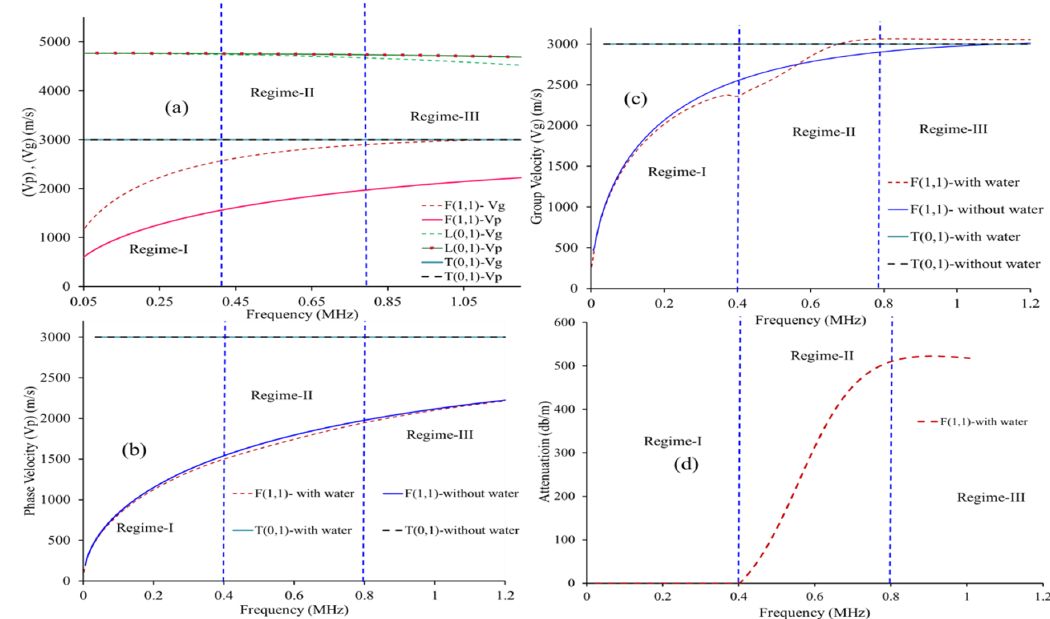
Figure 1. ( a ) Dispersion curves of 1.00 mm dia SS-308L waveguide in free boundary conditions (phase velocity (Vp) and group velocity (Vg)), [( b , c )] Vp and Vg at fluid (water) loaded, ( d ) Attenuation plot in water loaded condition.